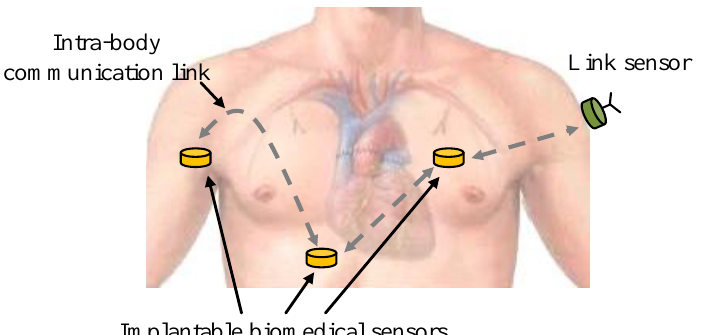
Implantable biomedical sensors